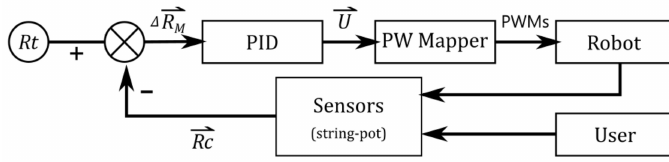
Figure 3. Control system